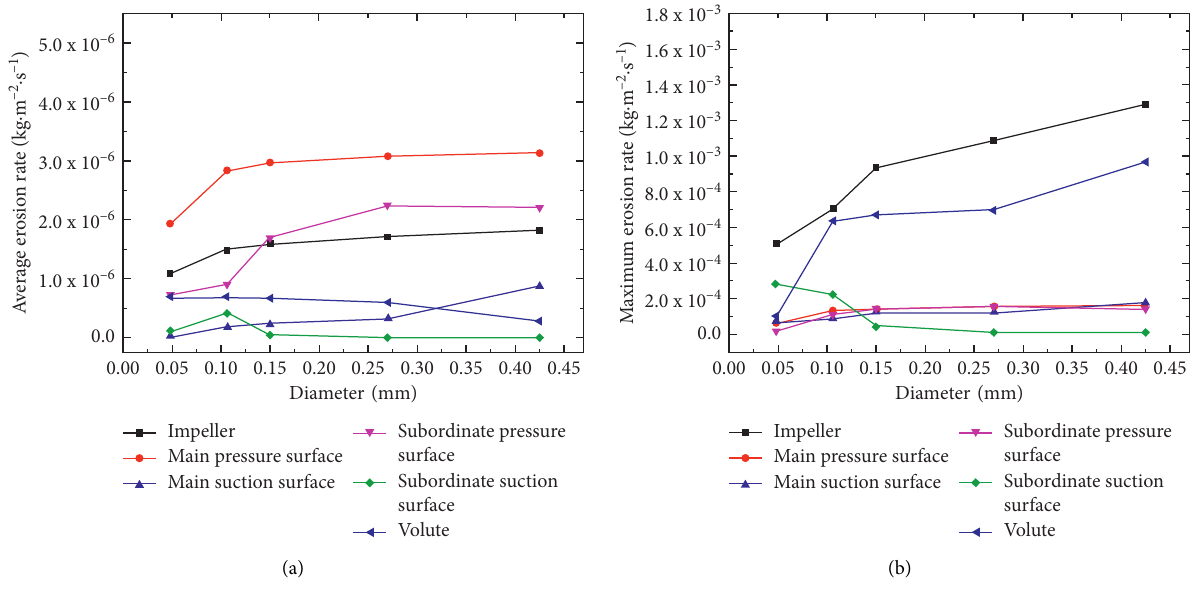
Figure 12: Comparison of wear rates of different parts at different particle sizes. (a) Average wear rate; (b) maximum wear